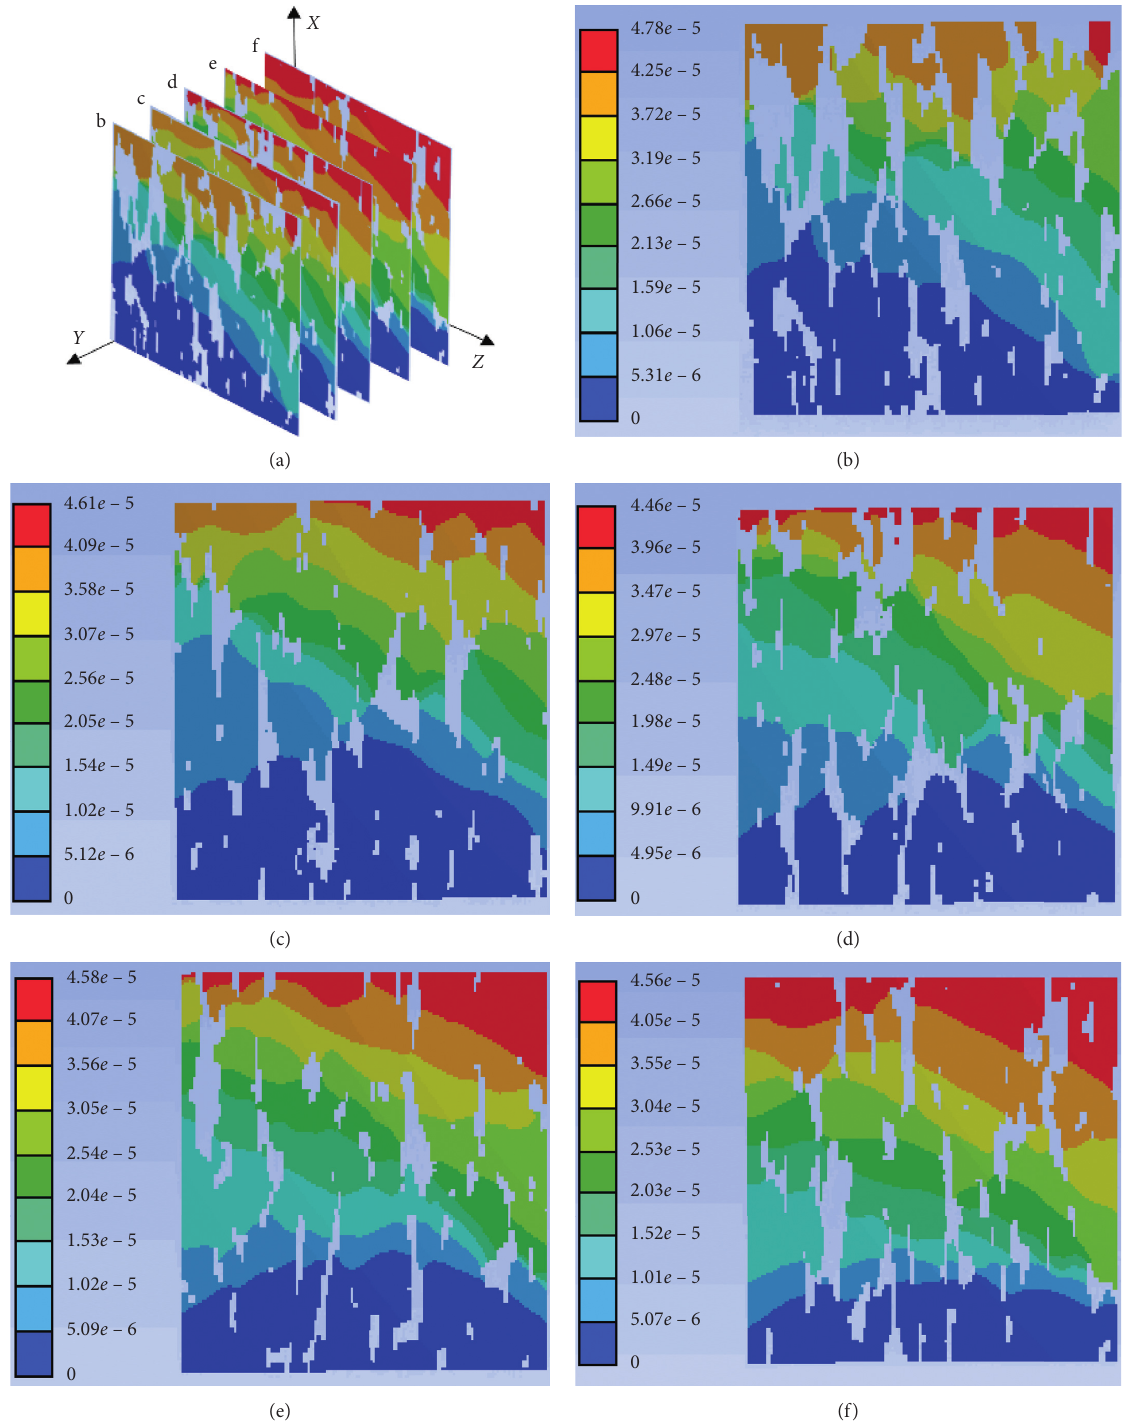
Figure 9: Cross-sections total displacement distribution of model S2 (unit: m): (a) spatial location of slices at (b) y � 1mm, (c) y � 0.8mm, (d) y � 0.6 mm, (e) y � 0.4mm, and (f) y �